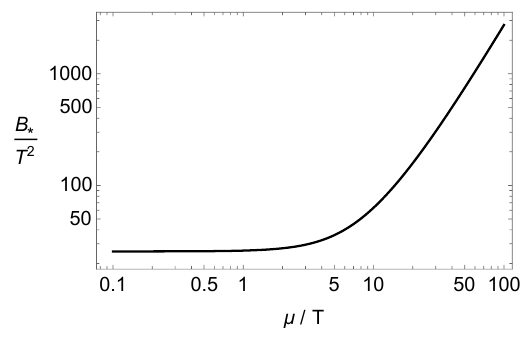
Figure 8 . Critical magnetic field B ∗ vs. µ